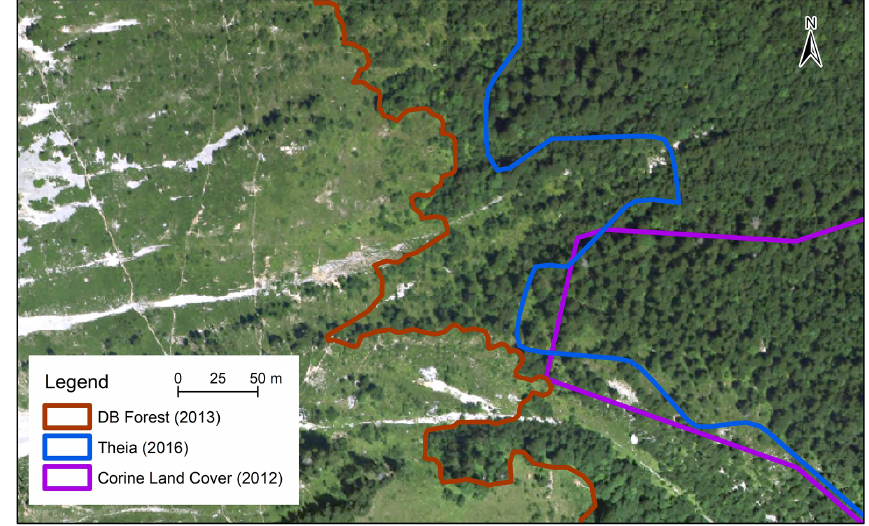
Figure 2. Comparison of forest extents from Theia, CORINE Land Cover, and DB Forest from IGN with aerial photographs (© IGN) taken in 2012 within the municipality of Le Sappey-en-Chartreuse, Chartreuse/Dent de Crolles study